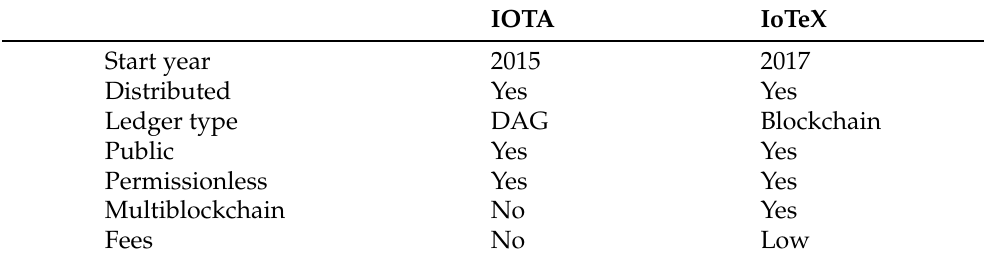
Table 3. IOTA and